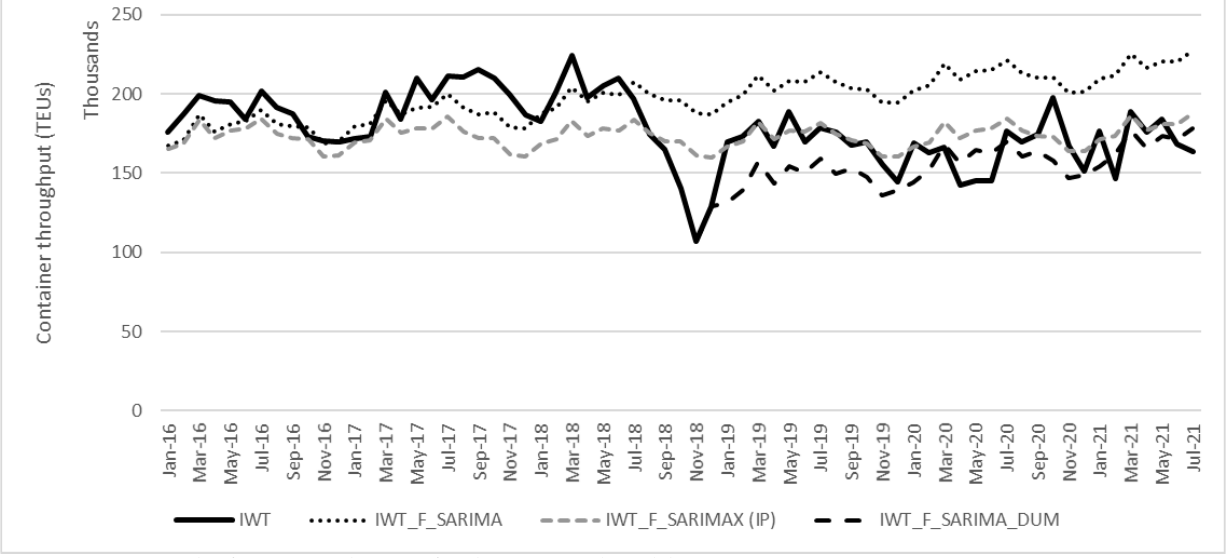
The forecast evaluation for the estimated